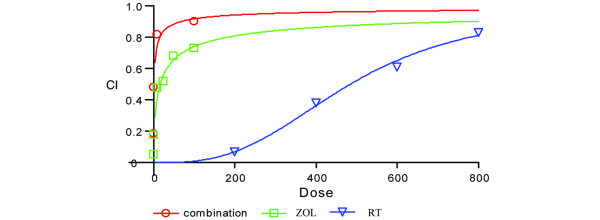
The combination index (CI) for the cell treatments with zoledronic acid (ZOL) and radiation (RT) for 24 and 72 hours. CI < 1.0 clearly points to a synergistic effect.